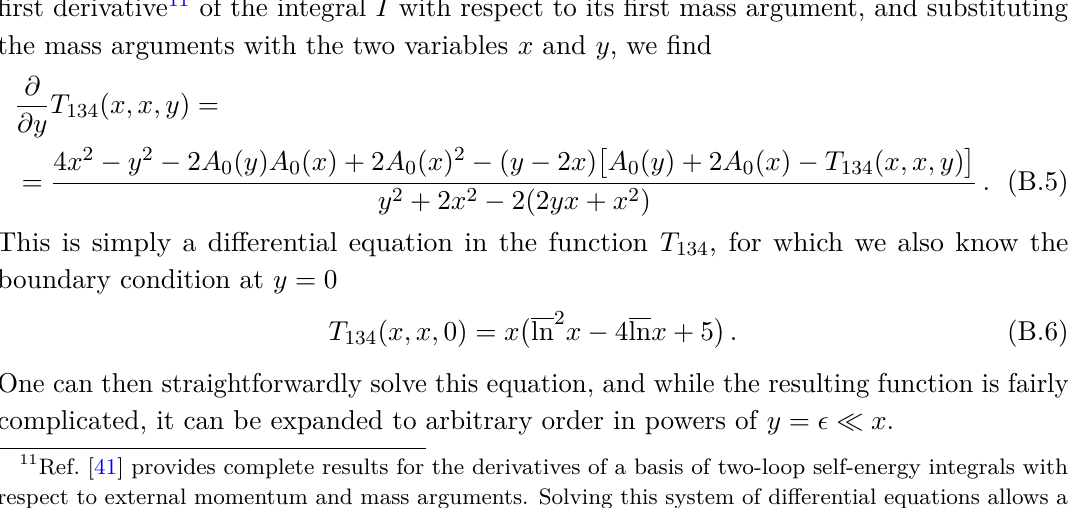
Table 1. Sample values of the integrals T 134 ( x, x, (cid:15) ) , T 1234 ( x, (cid:15), x, x, x ) , T 1234 ( x, x, (cid:15), x, (cid:15) ) , and T 12345 ( x, x, (cid:15), x, (cid:15), x ) — multiplied by powers of x to obtain a dimensionless quantity — for the mass parameter assignments ( a ) , ( b ) , ( c ) given in eq. (B.4). We compare values obtained using the program TSIL [59] with those from our approximate expansion, at different orders in (cid:15) . Note that as the integral T 12345 is UV finite, there is no Q dependence in the corresponding loop